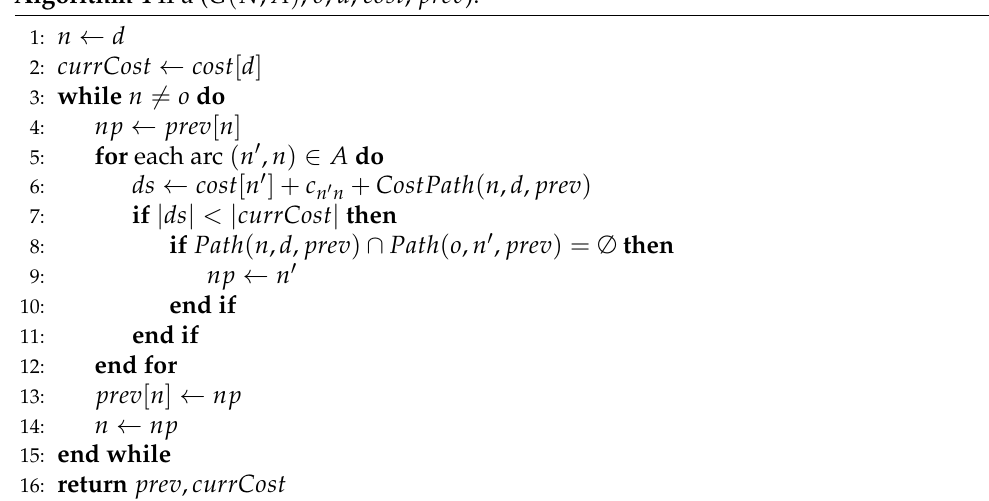
Algorithm 4 IPa ( G ( N , A ) , o , d , cost , prev